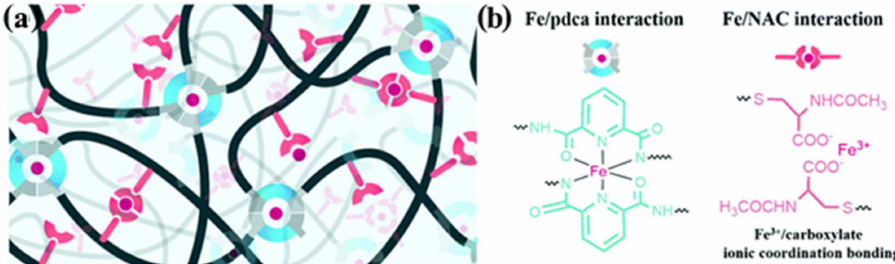
Figure 20. ( a ) Schematic representation of a dual-cross-linked PDMS network. ( b ) Illustration of the structures of the Fe / pdca complex (blue) and Fe / NAC complex (red), where pdca and NAC are pyridinedicarboxamide and N -acetyl- l -cysteine, respectively. Reproduced from [150] with permission from The Royal Society of